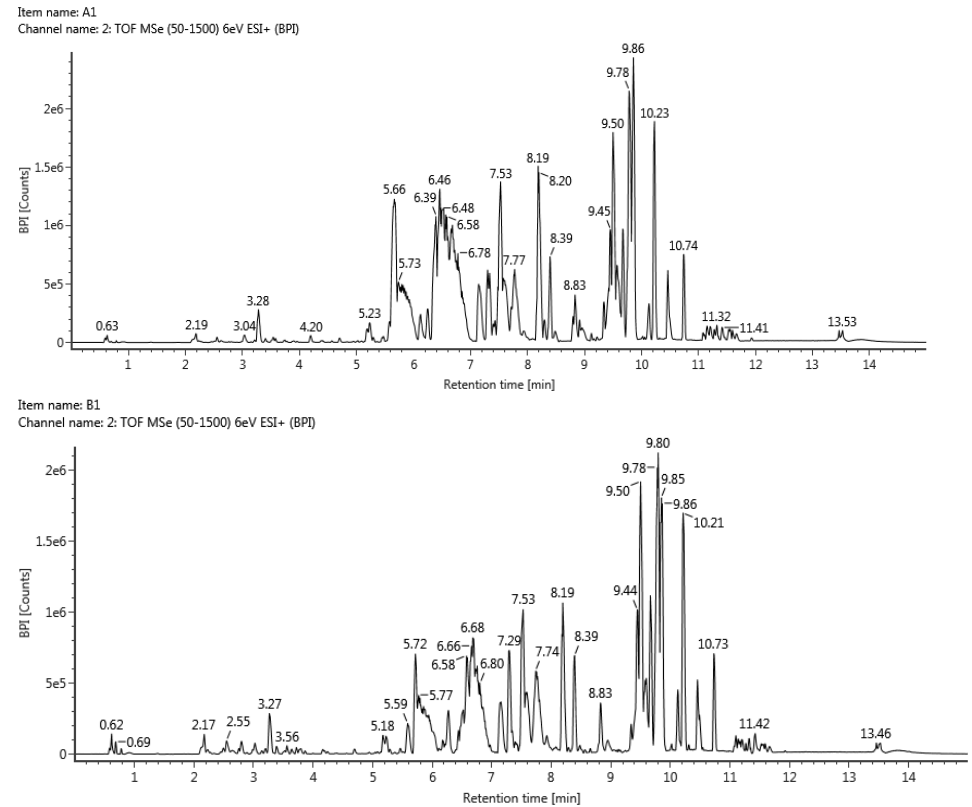
Figure 4. Extracted ion chromatograms of soyasapogenol metabolites in bile.